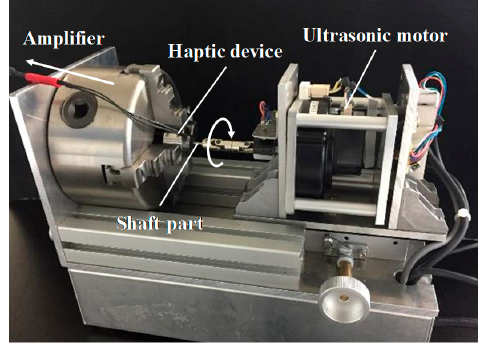
Figure 2. Snapshot of the torque evaluation system.